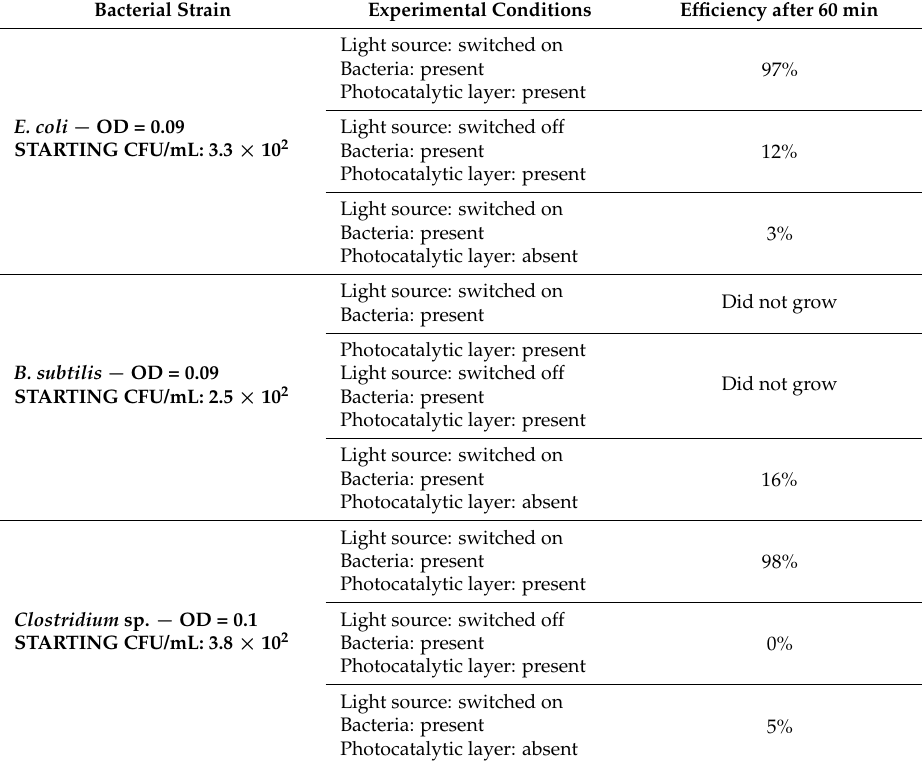
Table 3. Efficiency of bacteria inactivation in aqueous phase in the presence of the Ti 95 Cu 5 _30V sample and visible light ( λ > 420